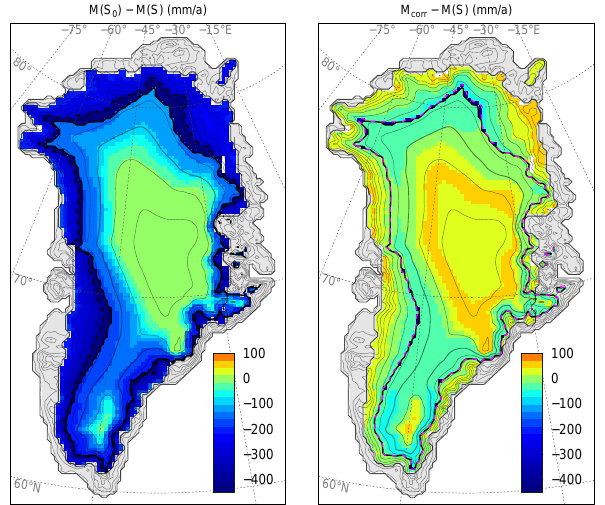
Figure 6. Error in melt (mma − 1 ) for a 3 ◦ C summer tempera- ture anomaly at 126kaBP calculated with the reduced (left) and insolation-corrected (right) model, compared to melt from the full model. The solid and dashed black lines in the left panel show the equilibrium line altitudes for the full ( M(S) ) and reduced model ( M(S 0 ) ), respectively. The dashed magenta line in the right panel shows the same for the insolation-corrected